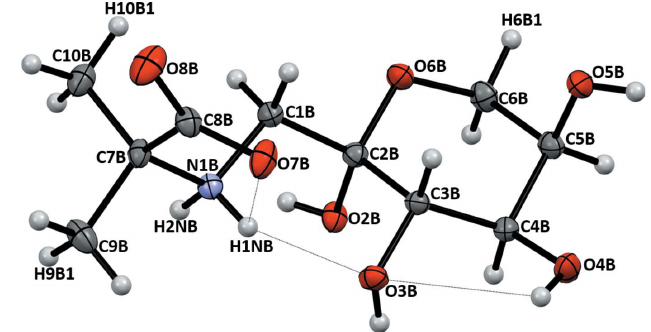
Figure 3 Atomic numbering and displacement ellipsoids at the 50% probability level for molecule (I B ). Intramolecular N—H (cid:5)(cid:5)(cid:5) O and O—H (cid:5)(cid:5)(cid:5) O interactions are shown as dotted lines.